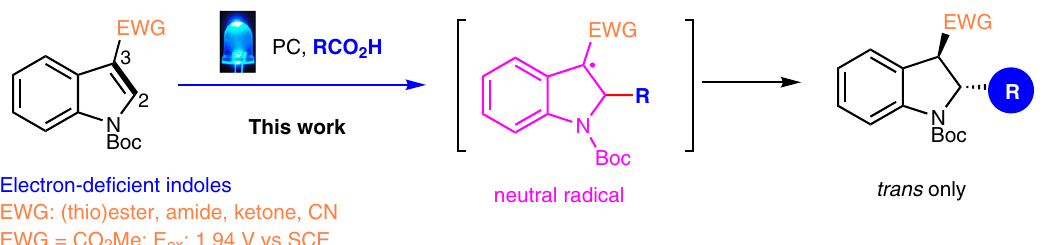
Fig. 1 The synthesis of indolines by radical engaged dearomatization of indoles. a Dearomatization of indoles via oxidative SET of C2 = C3 bond (known). b Giese reaction: radical addition to simple α , β -unsaturated systems. c Dearomatization of indoles via a Giese-type transformation (this